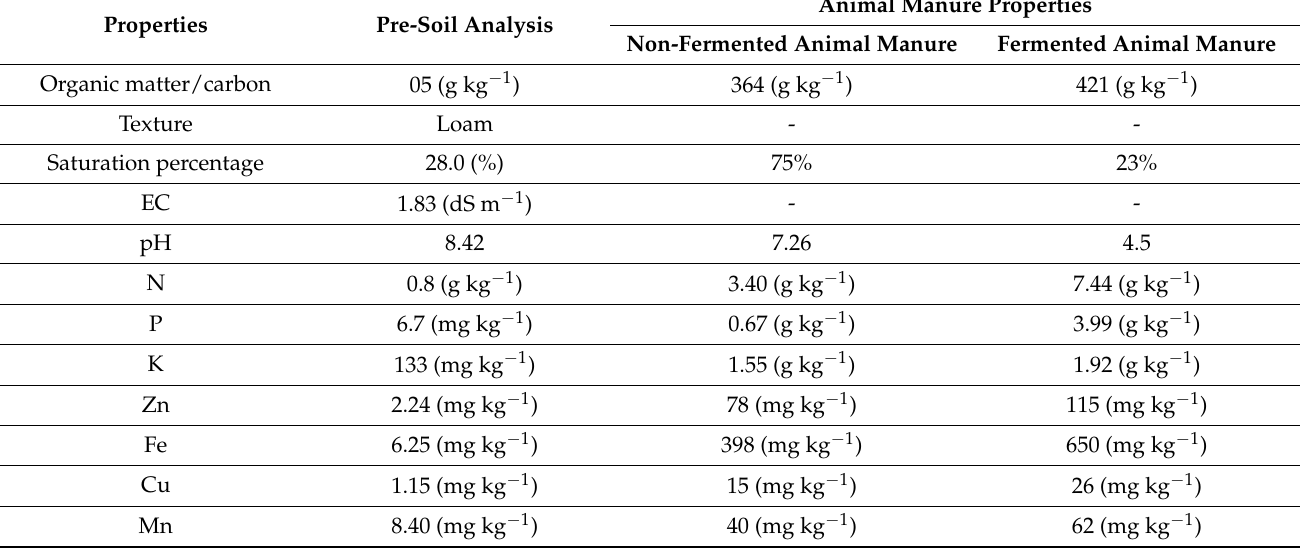
Table 2. The measured physico-chemical properties of soil with fermented and non-fermented animal manures used in the